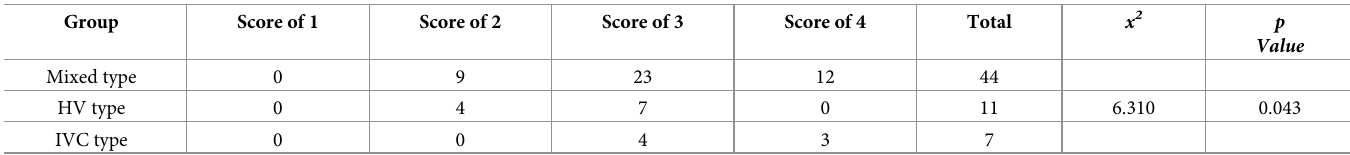
Table 2. Diagnostic confidence subjective score for different types of BCS.